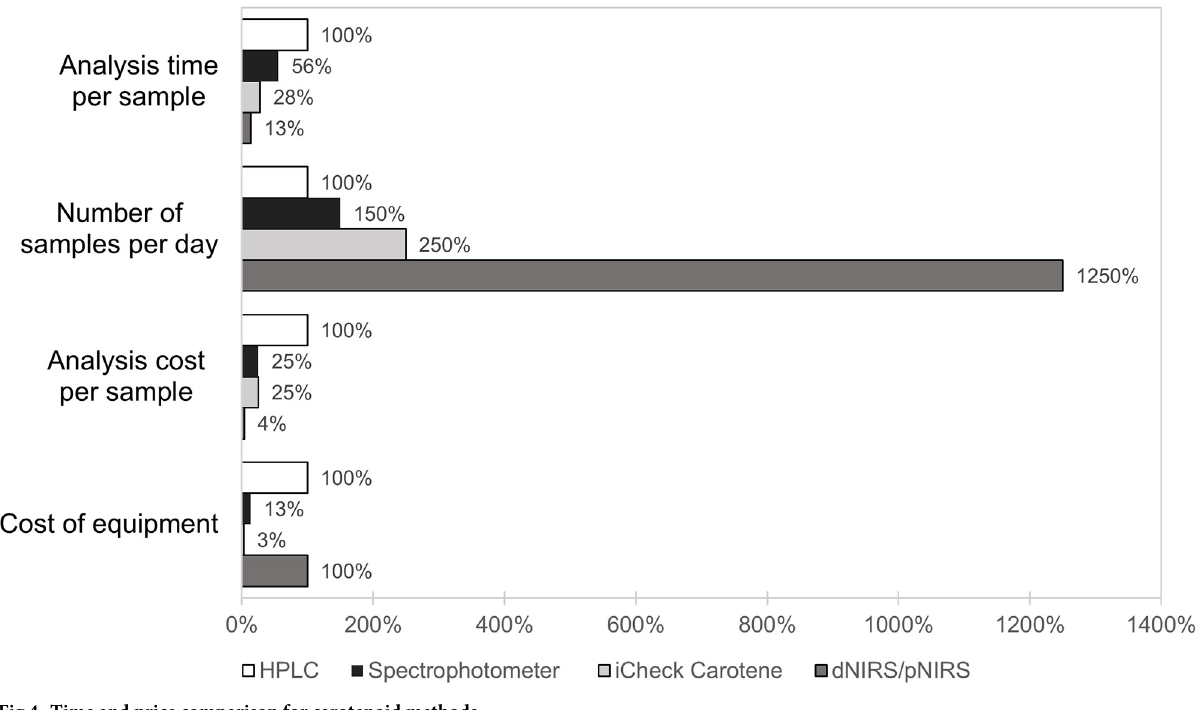
Fig 4. Time and price comparison for carotenoid